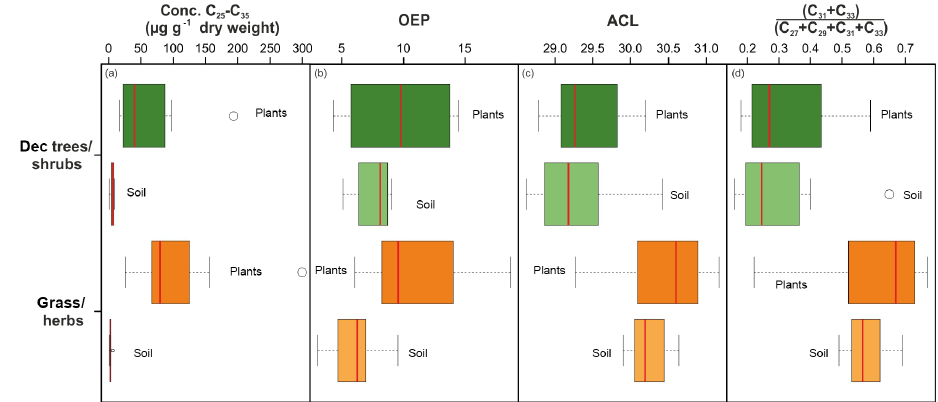
Figure 3. Box plots of n -alkanes from modern plant and topsoil samples. (a) Concentration µgg − 1 (C 25 -C 35 ), (b) odd-over-even pre- dominance (OEP), (c) average chain length (ACL), (d) n -alkane ratio ( C 31 + C 33 )/( C 27 + C 29 + C 31 + C 33 ) . Dec = sites with deciduous trees/shrubs ( n = 16); grass = sites with grassland/herbs ( n = 28). The box plots show median (red line), interquartile range (IQR) with upper (75%) and lower (25%) quartiles (full rectangles) and outliers (dashed lines).